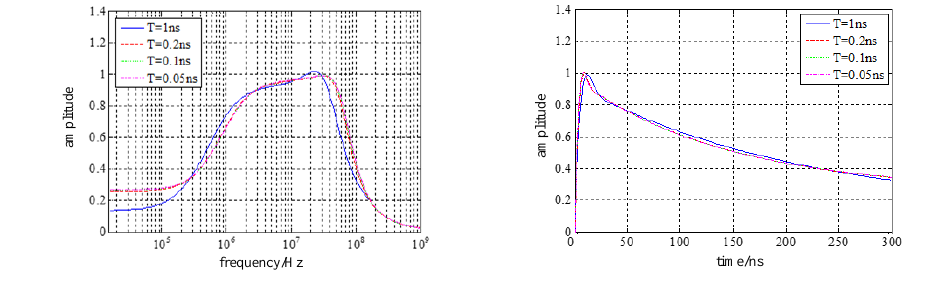
Fig. 5. Amplitude-frequency response of B sensor. Fig. 6. Step response of B